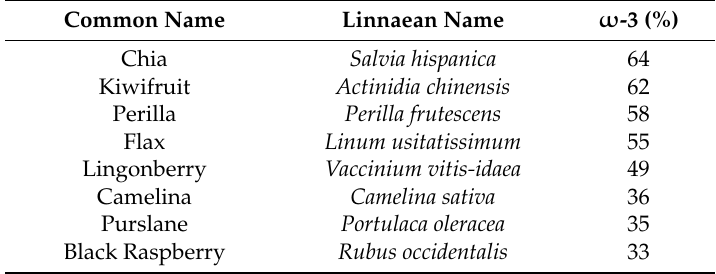
Table 20. ω -3 content (%) of α -linolenic acid (ALA) in seed oils. Reprinted with permission from